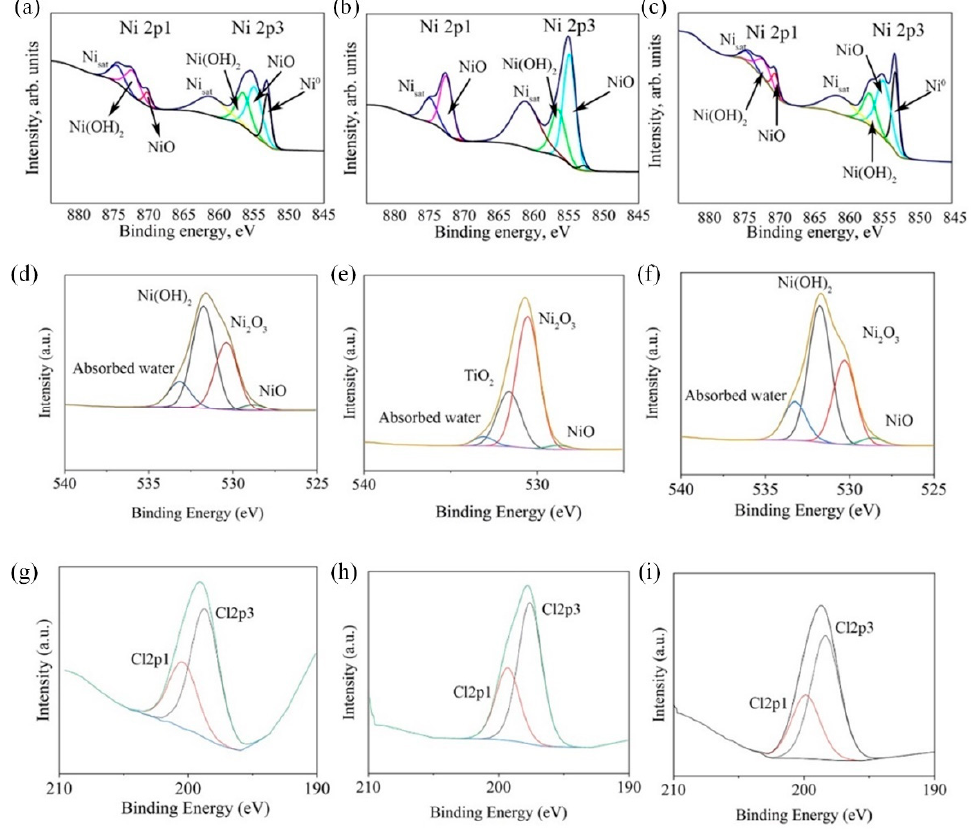
Figure 10. High-resolution XPS spectra for Ni2p ( a − c ), O1s ( d − f ) and Cl2p ( g − i ) registered after 3.5 month of immersion in 0.5 M NaCl: ( a , d , g ) Ni, ( b , e , h ) Ni-TiO 2 , ( c , f , i ) Ni-CeO 2